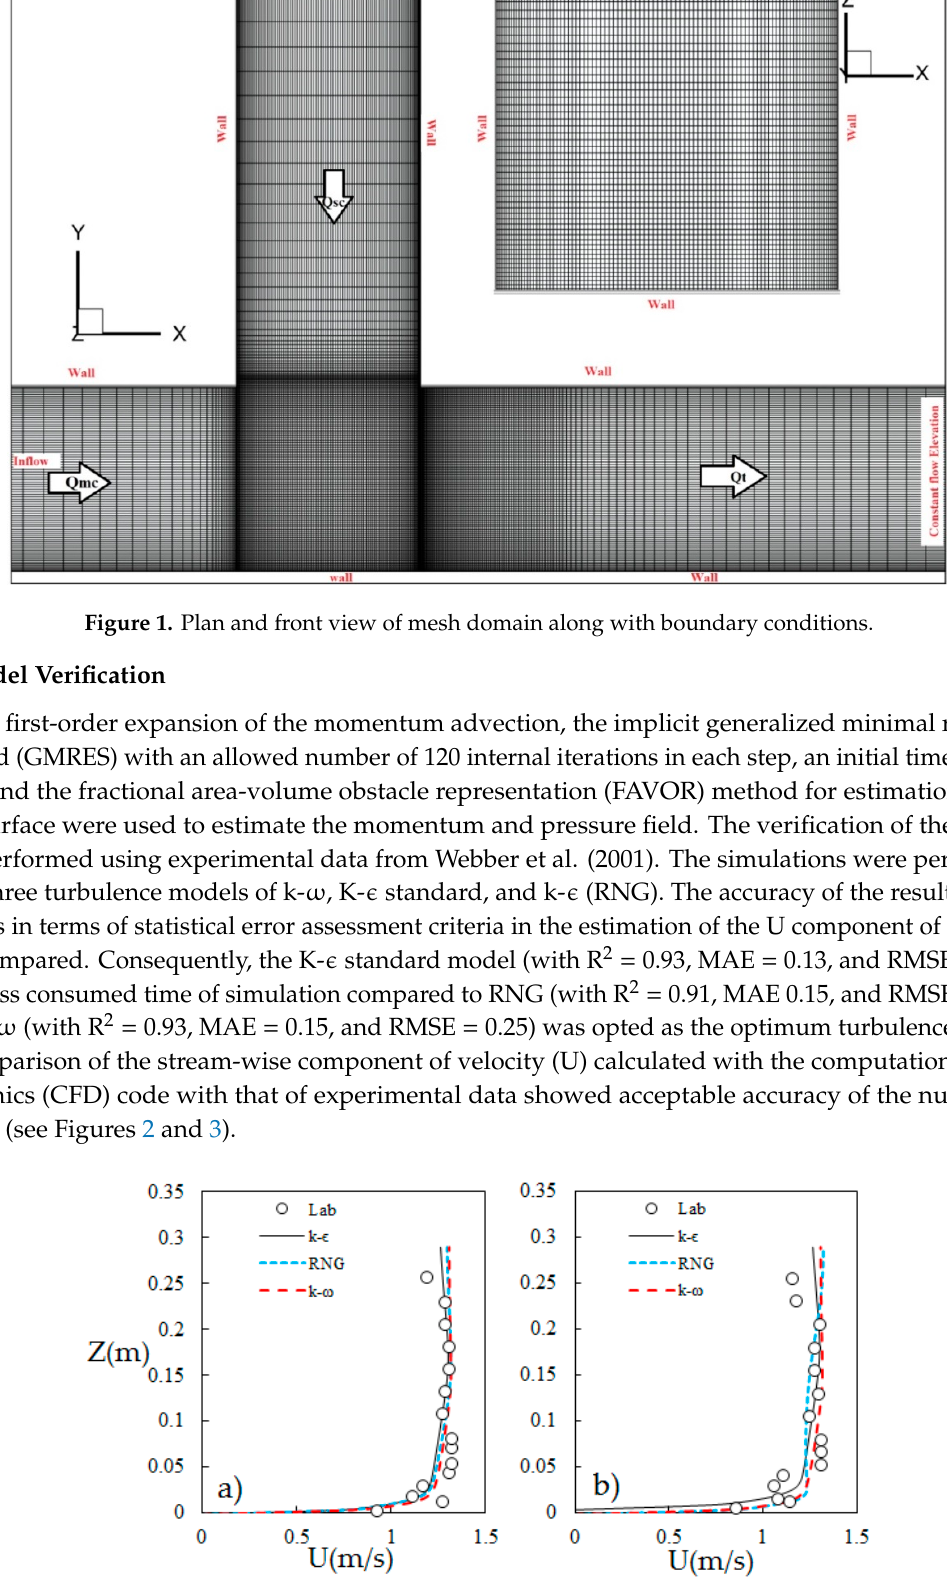
Figure 2. A comparison of the accuracy of velocity calculations from different turbulence models in estimating U-component of velocity at x = 8.82 (x* = 2 Wc) and ( a ) y = 0.25 Wc, and ( b ) y = 0.5Wc.